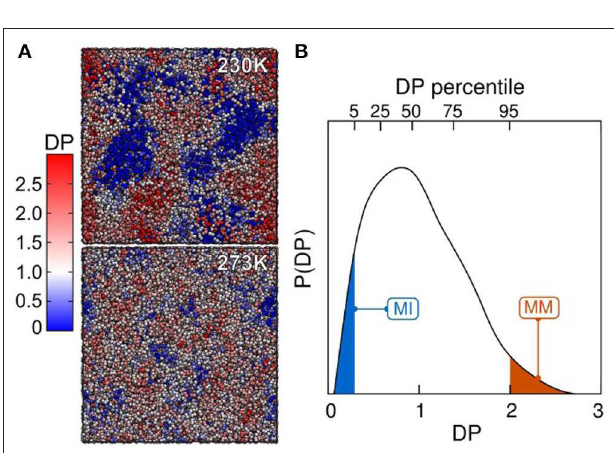
FIGURE 2 | Dynamical heterogeneity in supercooled liquid water. (A) Spatial distribution of the dynamical propensity (DP, the tendency of each molecule to move) at 230 and 273K. Molecules (only oxygen are shown) are colored based on the scale on the left. (B) Probability density distribution of the DP at 230K. Shaded regions in blue and red underline the 5% most immobile (MI) and most mobile (MM) molecules (reprinted from [21] under the Creative Commons CC BY-NC-ND